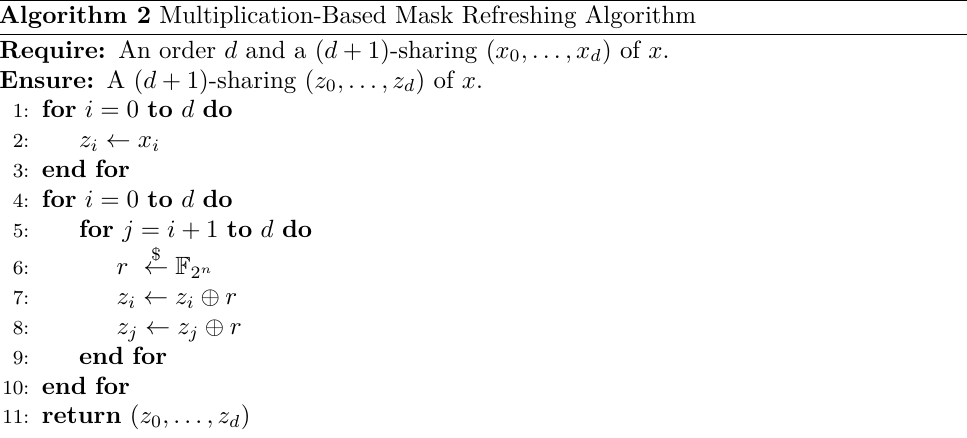
Algorithm 2 Multiplication-Based Mask Refreshing Algorithm